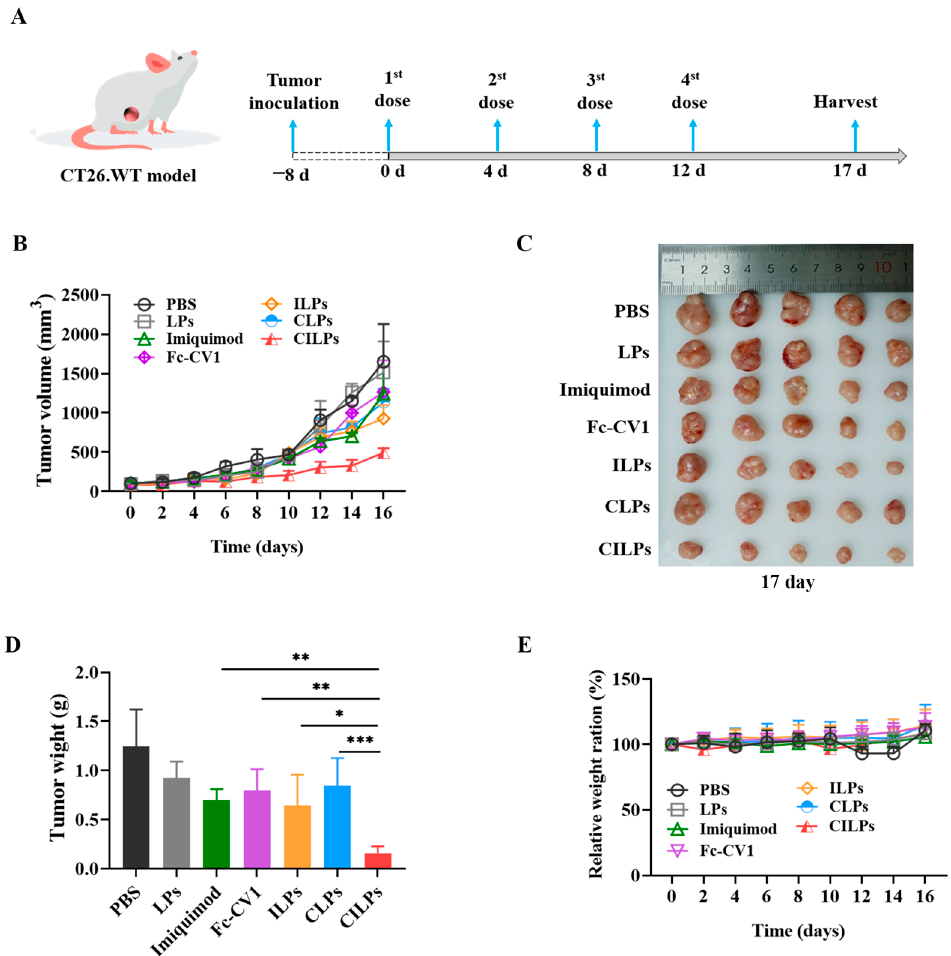
Figure 6. ( A ) Schematic illustration of anti-colon cancer treatment on the CT26.WT tumor model. ( B ) The growth curves of tumor volume during the treatment period. ( C ) Relative tumor photographs and ( D ) weight of the tumor collected from different treatment groups on day 17. ( E ) The relative body weight ratio of the body weight compared with 0 day. Data are presented as mean ± standard deviation ( n = 5). * p < 0.05, ** p < 0.01, *** p < 0.001.